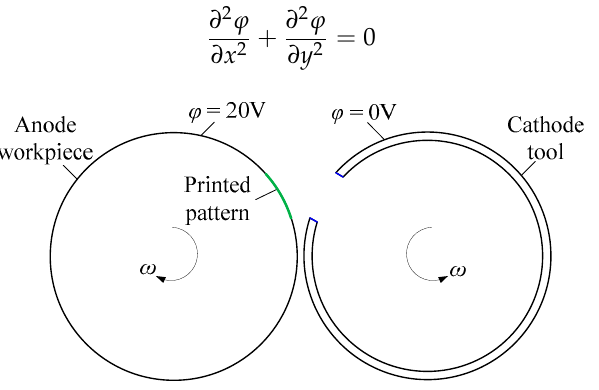
Figure 6. Numerical simulation model in cross-section.